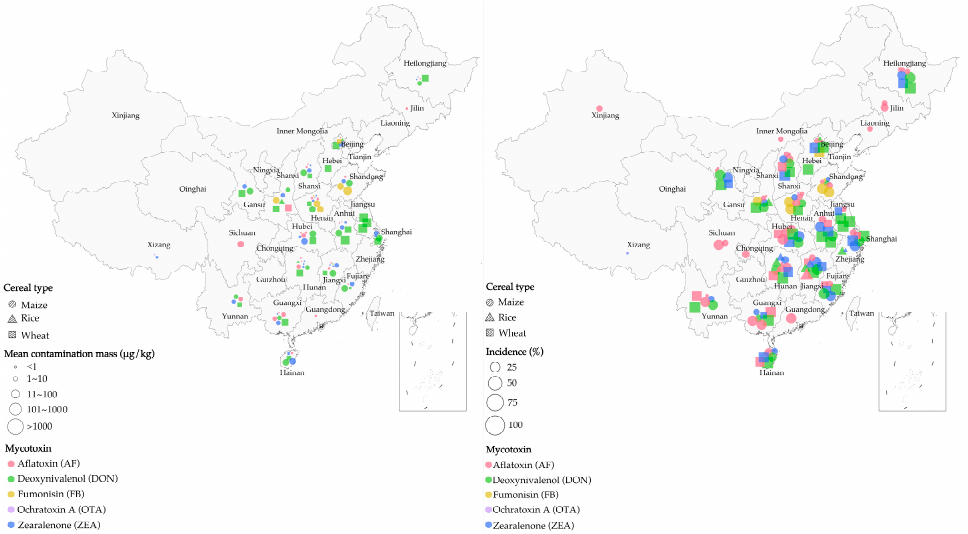
Figure 1. Mycotoxin contamination of cereals (maize, rice, and wheat) in surveys across China. ( Left ) mean mass of cereal contamination in di ff erent regions; ( right ) incidence of cereal contamination in di ff erent regions. (Source: our own study.)